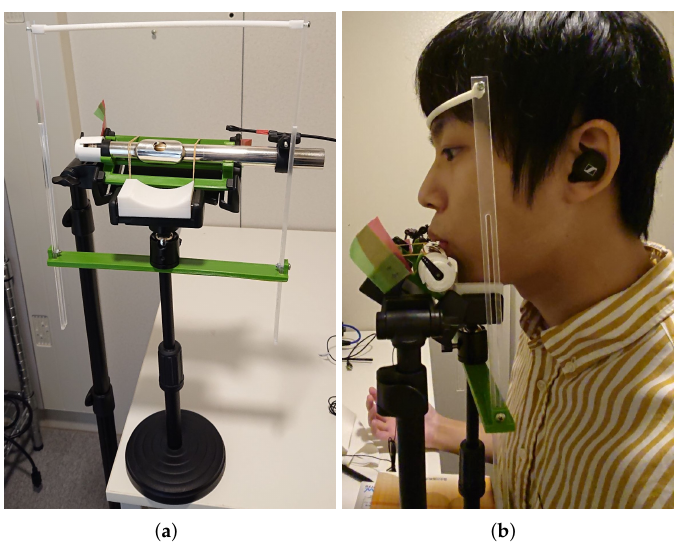
Figure 4. A head fixation device was developed for collecting human performance data. ( a ) Head fixer device. ( b ) Usage